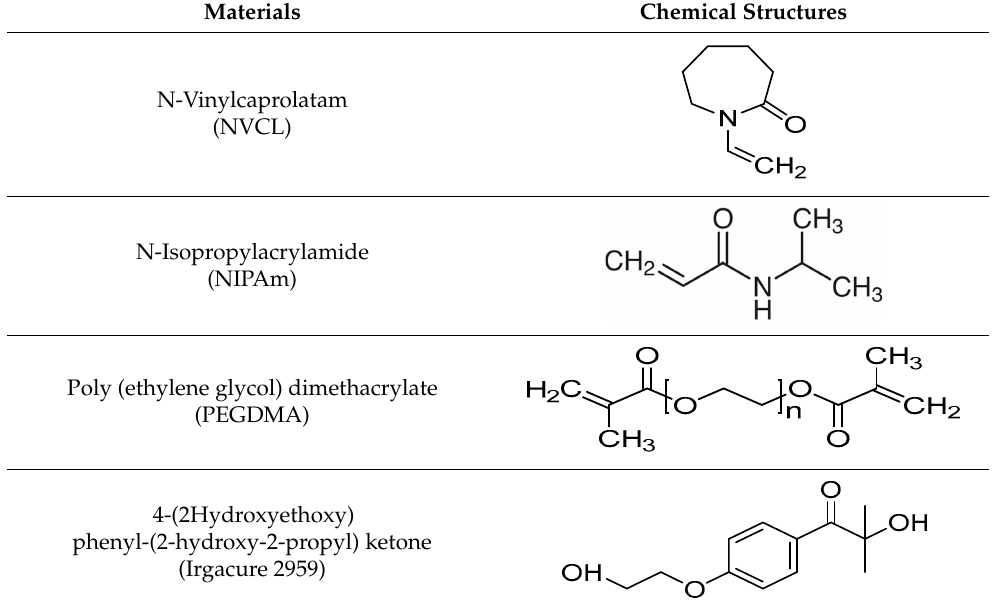
Table 3. Materials used and their chemical structure.